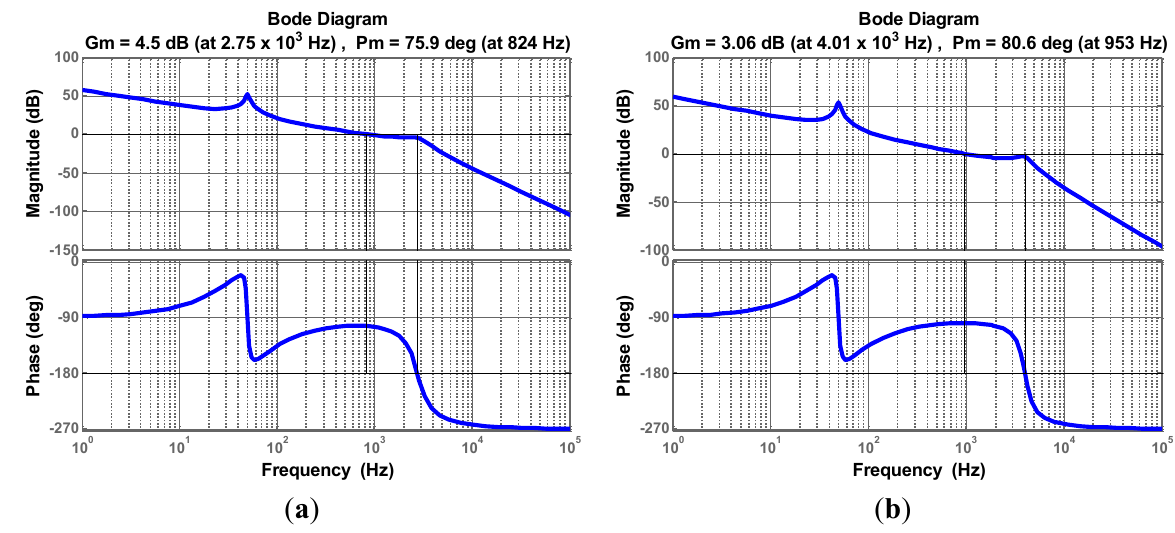
Figure 14. System Bode diagram under different parameters: ( a ) inductor L 150%; ( b ) inductor L decreased by 20%. 2